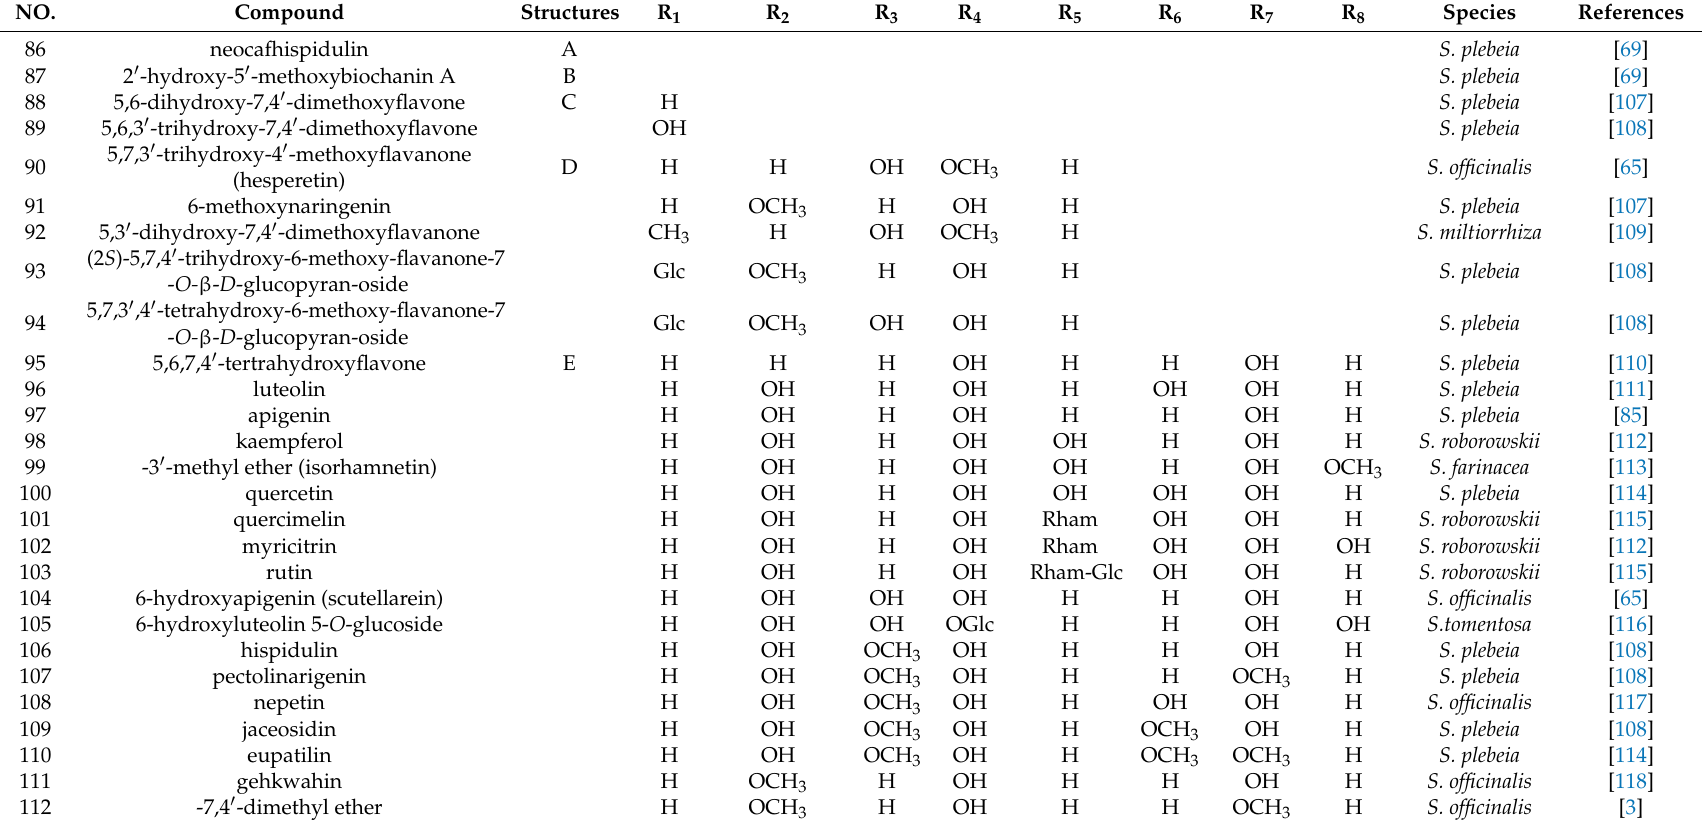
Table 2. The flavonoids in Salvia